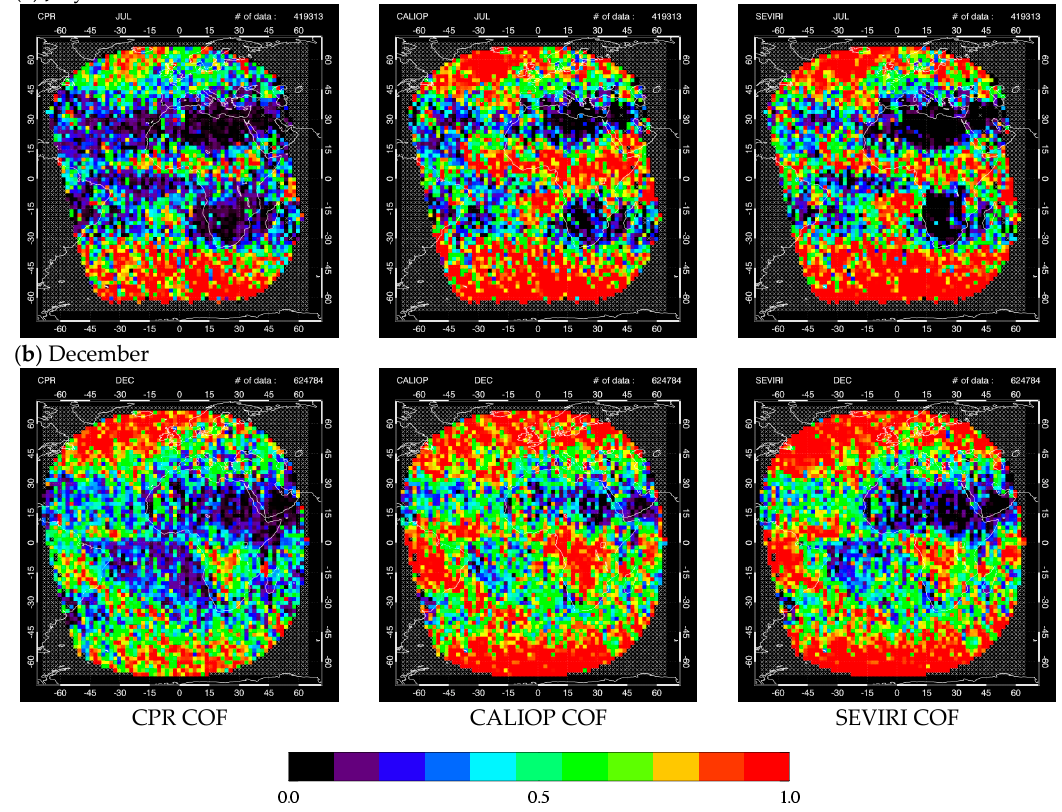
Figure 2. Cloud occurrence frequency maps for Cloud Profiling Radar (CPR), Cloud-Aerosol LiDAR with Orthogonal Polarization (CALIOP), and Spinning Enhanced Visible and Infrared Imager (SEVIRI). The upper panel ( a ) is from 11 to 31 July 2013, and the lower panel ( b ) is from 1 to 31 December 2013.